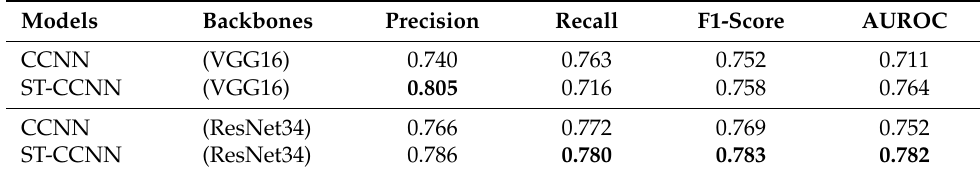
Table 7. Ablation study of with/without ST on single modality datasets TNO.